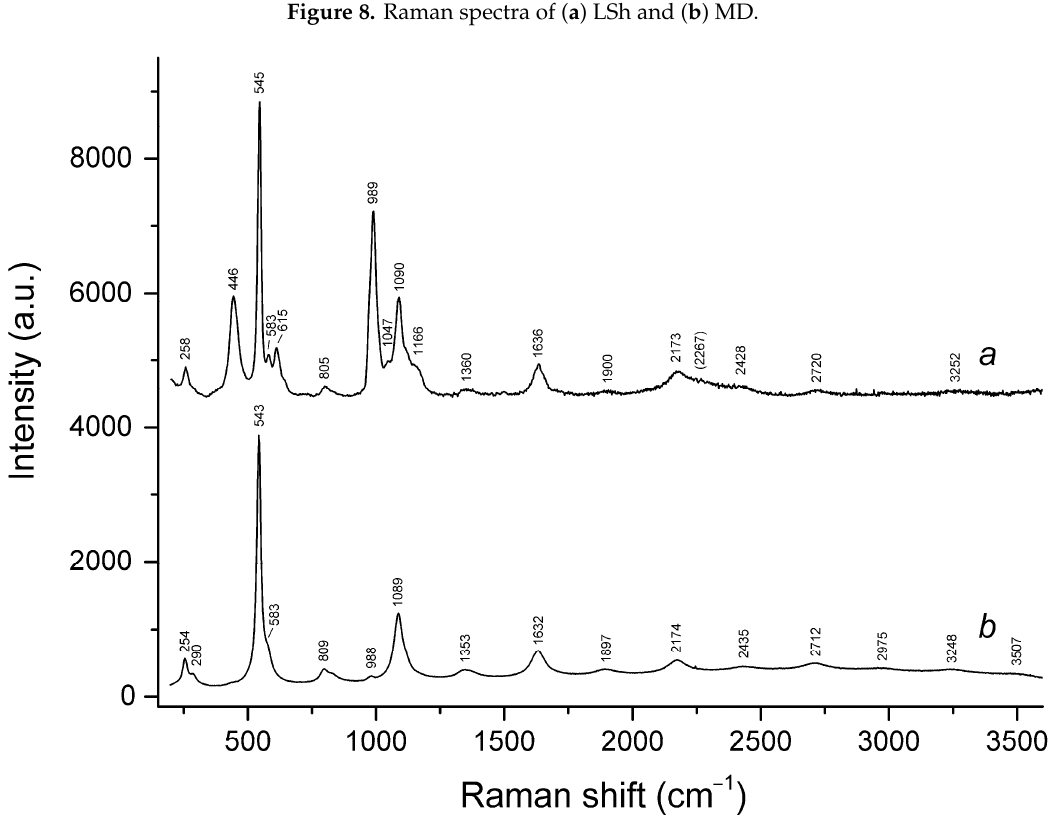
Figure 8. Raman spectra of ( a ) LSh and ( b ) MD.